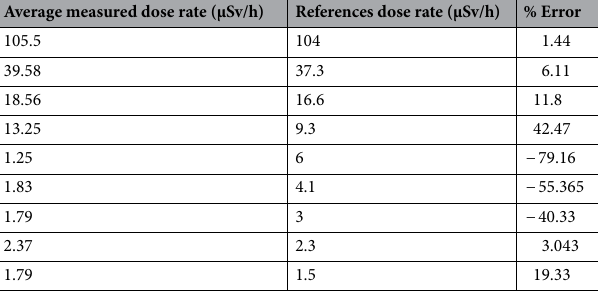
Table 1. Error percentages from the dose rates at the calibrated source measurements.